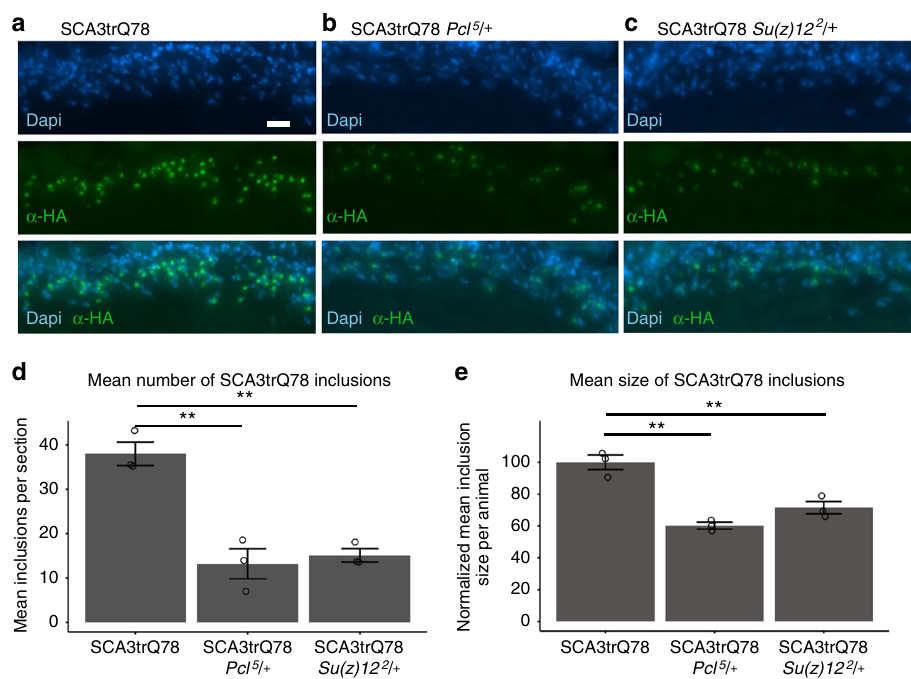
Fig. 6 PRC2 mutations suppress accumulation of pathogenic polyglutamine protein. a Animals expressing SCA3trQ78 in the photoreceptor cells have prominent nuclear inclusions. 3d animals, antibody to HA tag present on the SCA3trQ78 transgene (green). Dapi (blue), nuclei. Genotype: rh1-GAL4, UAS- SCA3trQ78/ + . Scale bar indicates 10 μ m. b Decreasing Pcl activity decreased SCA3trQ78 inclusions of 3d animals. Genotype: Pcl 5 / + ; rh1-GAL4, UAS- SCA3trQ78/ + . c Decreasing Su(z)12 activity decreased SCA3trQ78 inclusions of 3d animals. Genotype: rh1-GAL4, UAS-SCA3trQ78/Su(z)12 2 . d Average number of inclusions detected in the region of interest in various genotypes. Mean± SEM, n = 3 animals, using the average of at least 4 sections per animal. F 2,6 = 27.84, p < 0.001, one-way ANOVA, with Tukey post-test ** p < 0.01. e Mean size of inclusions. The size of inclusions detected in at least 4 sections per animal was determined, with the control cohort adjusted to 100%. The average size of inclusions was smaller in animals heterozygous for Pcl 5 or Su(z)12 2 . Mean ± SEM, n = 3 animals, using the average of at least 4 sections per animal. F 2,6 = 30.89, p < 0.001, one-way ANOVA, with Tukey post-test, ** p < correspond to a younger age pro fi le, if targets of PRC2 relevant to aging of the brain are impacted.